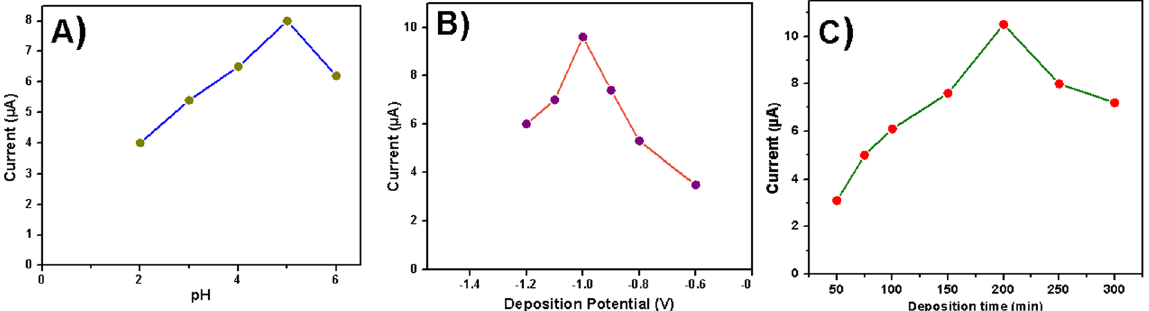
Figure 7. Effect of ( A ) pH of acetate buffer ( B ) Deposition potential of cadmium ( C ) Deposition time of cadmium on the DPSAV current in acetate buffer solution contained 50 µ g L − 1 of Cd (II) ion.